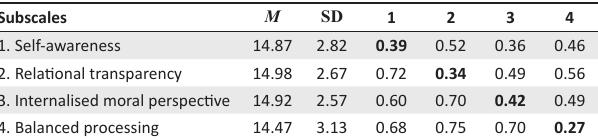
TABLE 2: Inter-correlations between latent Authentic Leadership Inventory dimensions, average variance extracted and shared variance estimates ( N = 213).